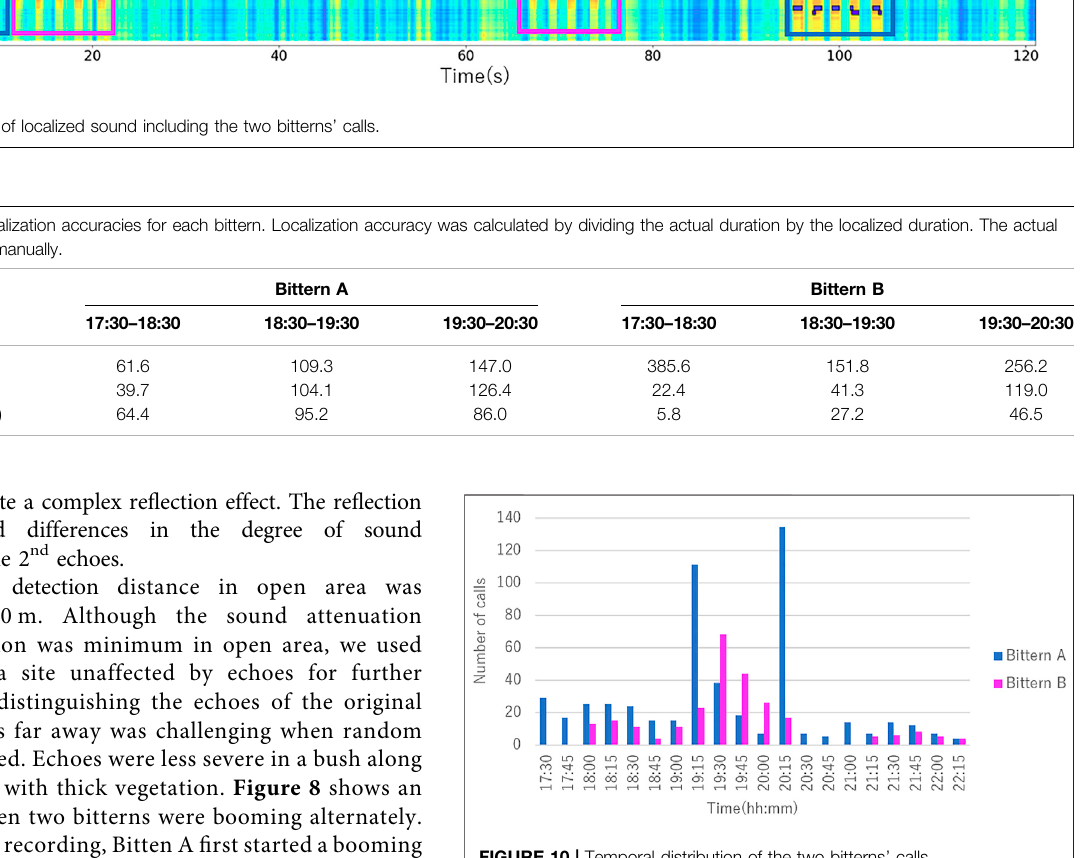
FIGURE 10 | Temporal distribution of the two bitterns ’